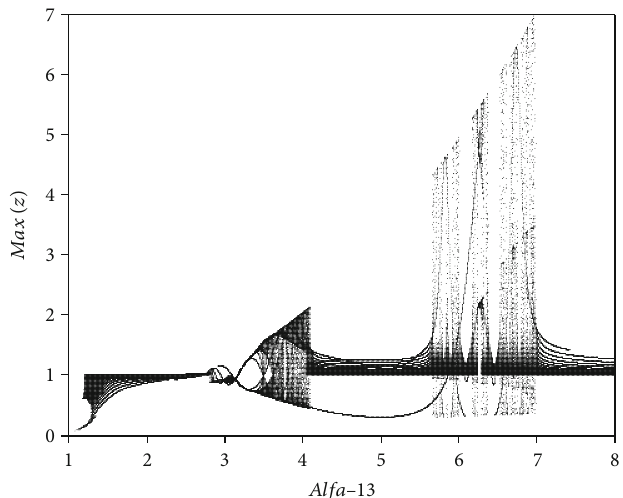
1 < α < 8 using the parameter values in 13 in the range 13